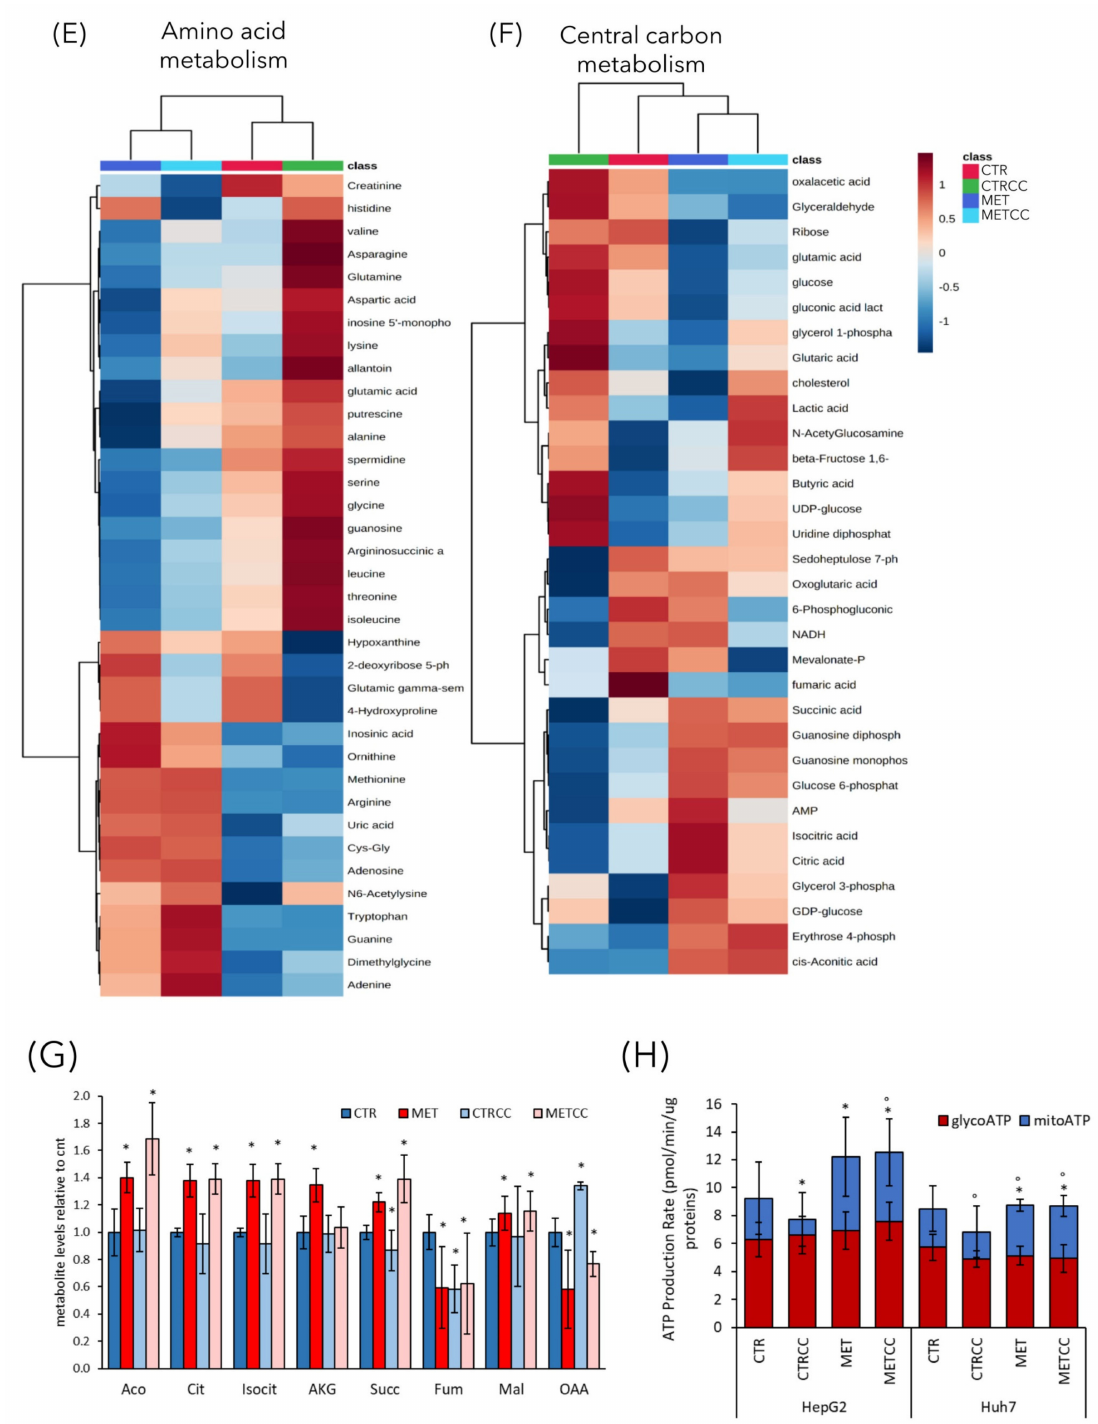
Figure 4. High methionine and Compound C affect cellular metabolism. ( A , B ) HepG2 ( A ) and Huh7 ( B ) cells were grown for 48 h in regular medium or in the presence of high methionine and / or Compound